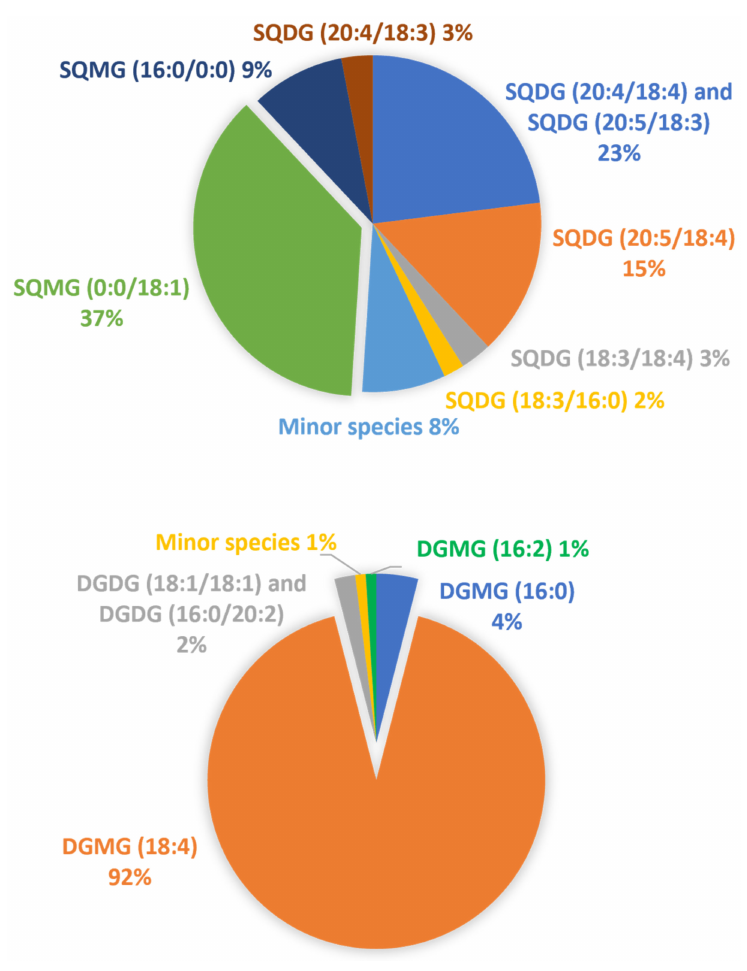
Figure 6. Representation of the relative abundance of the major SQDG (upper panel) and DGDG (lower panel) classes and the relevant lyso-forms (SQMG/DGMG) in the wakame seaweed lipid